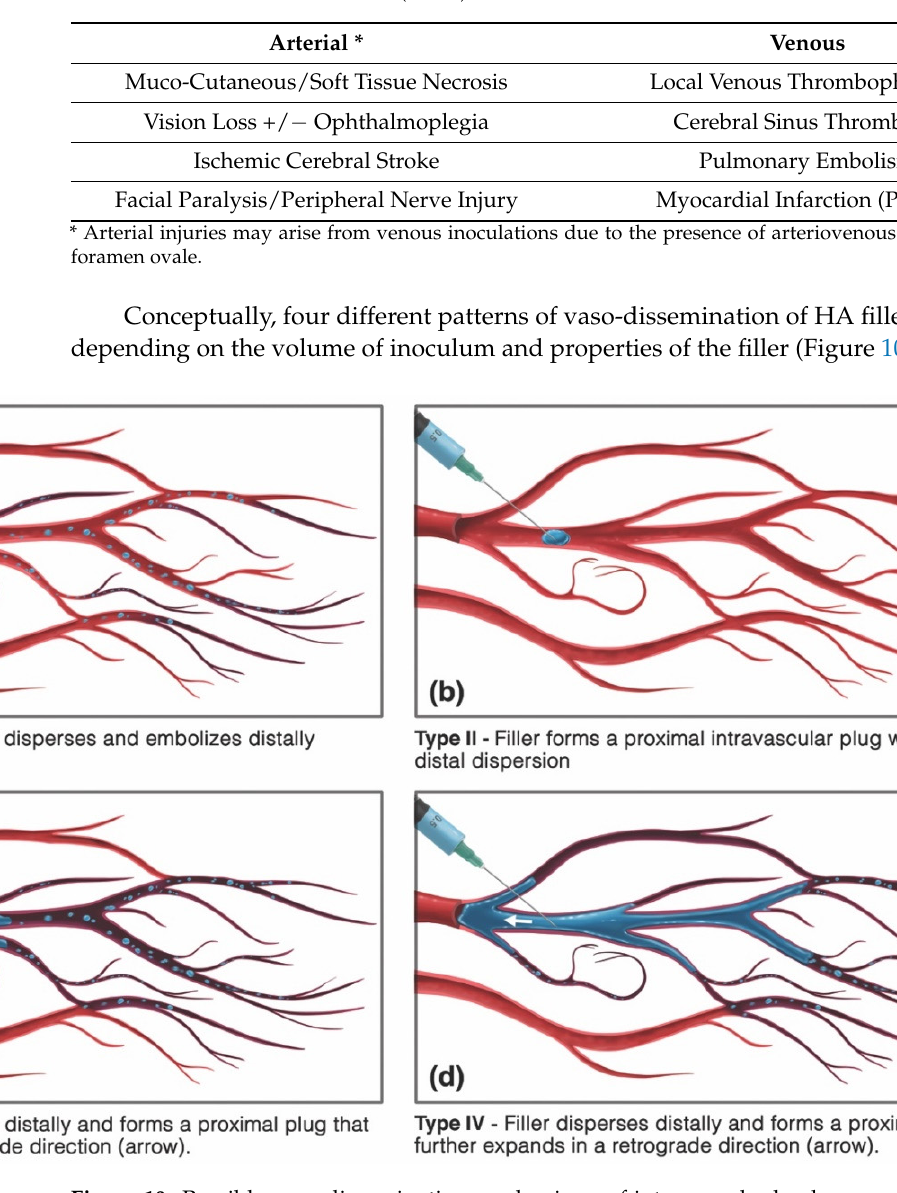
Table 2. Examples of proximal and distant arteriovenous occlusive sequelae that may arise from filler-induced vascular occlusion (FIVO) of facial-onset.